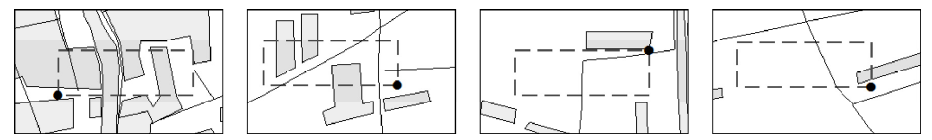
Figure 16. Conflicting labeling cases for the RoadResident instance.